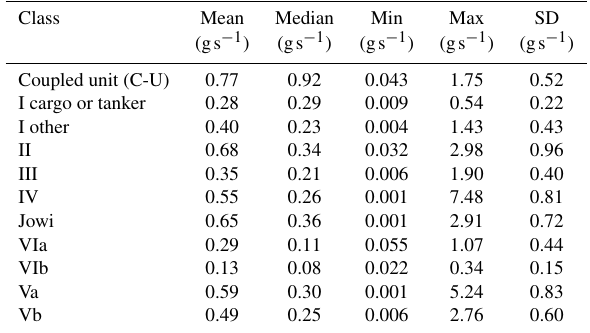
Table A1. Summary of data shown in Fig. 5. NO x emission rates for ships travelling upstream are derived from measurements at DURH.